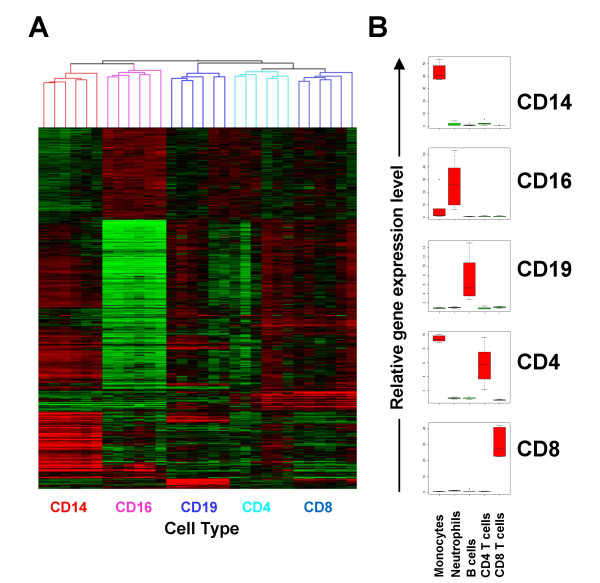
Microarray analysis of purified cell populations from six normal controls. (A) Hierarchical clustering of microarray data generated for five cell populations isolated from six normal controls was performed using expression data from 12,022 genes and clusters samples according to cell lineage. (B) Relative expression levels of CD14, CD16, CD19, CD4 and CD8 mRNA in each of the five cell types.